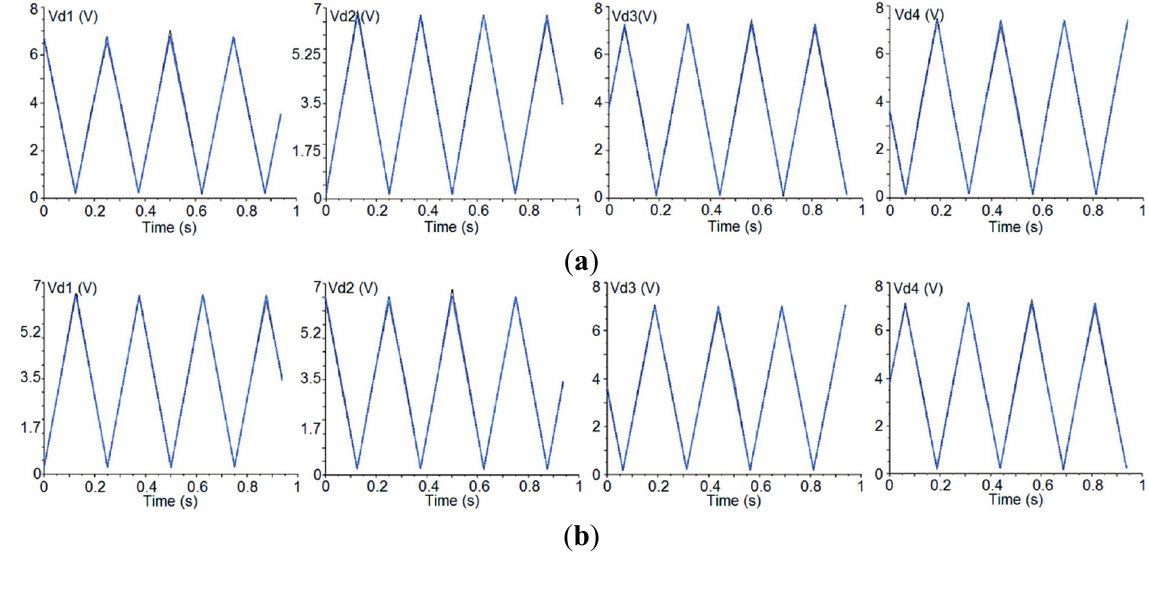
Figure 6. Second polarimeter example: Detected signals resulting from the phase-adjustment ( a ) and measurement ( b )